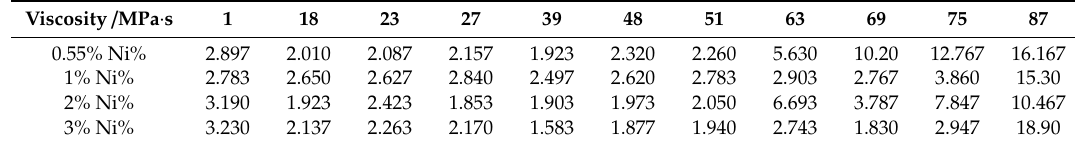
Table 1. Variation of sol viscosity of Ni with varying mass percentage over time.